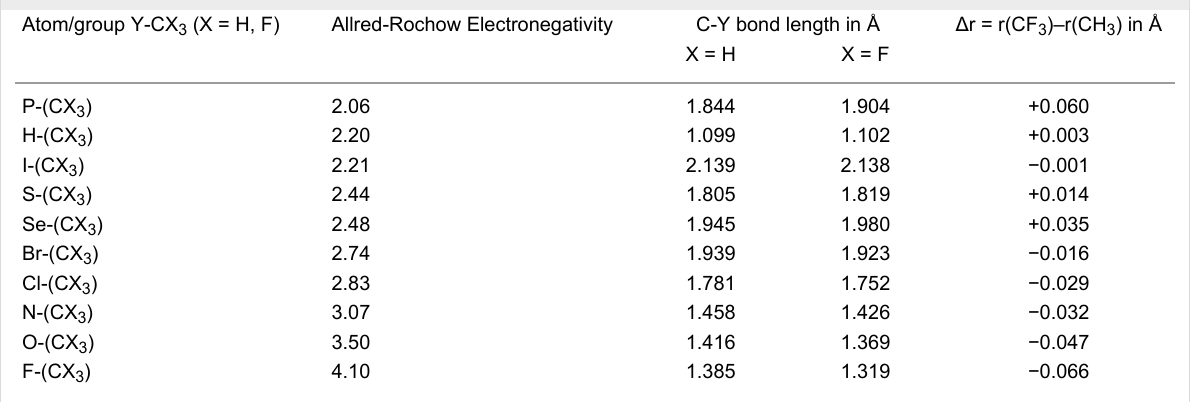
Table 6: Effect of substituting a trifluoromethyl group for methyl on different heteroatoms. Atom/group Y-CX 3 (X = H, F)